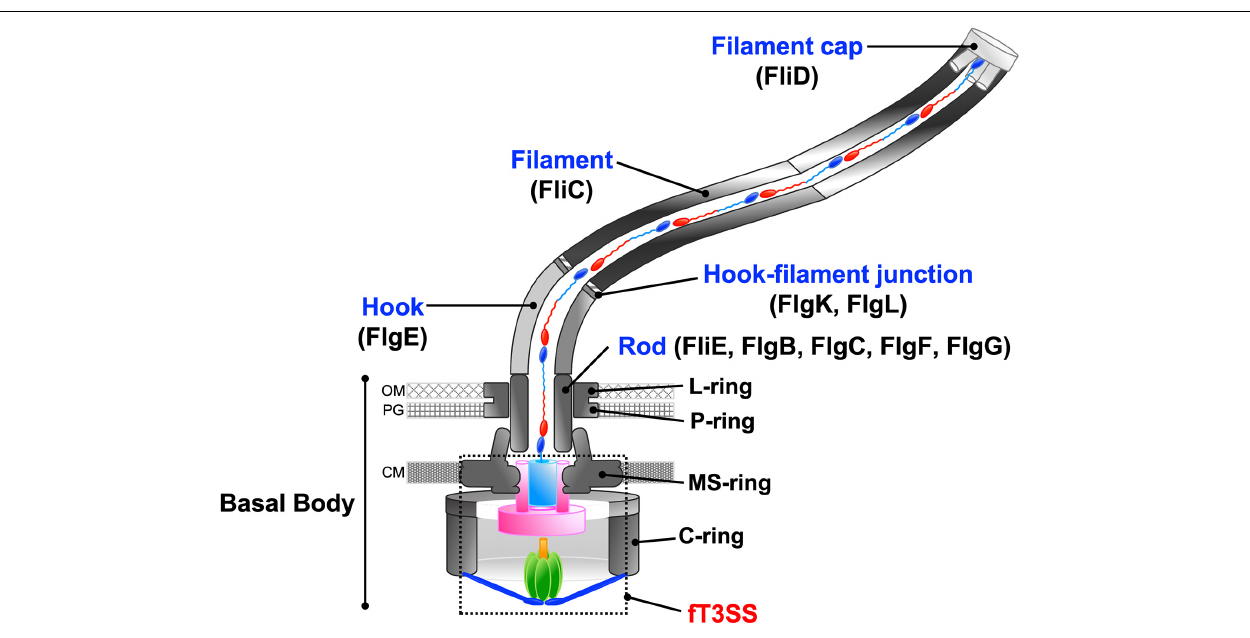
the entrance gate of the FliP 5 -FliQ 4 -FliR 1 complex through interactions of the loop with each FliQ subunit ( Figure 3 , right panel). It is thus plausible that FlhB may coordinate